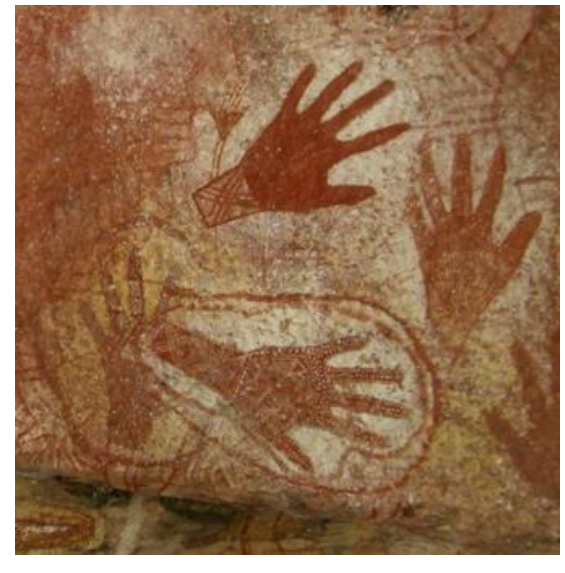
Figure 7. “Decorated hands”, Mt Borradaile, Arnhem Land,